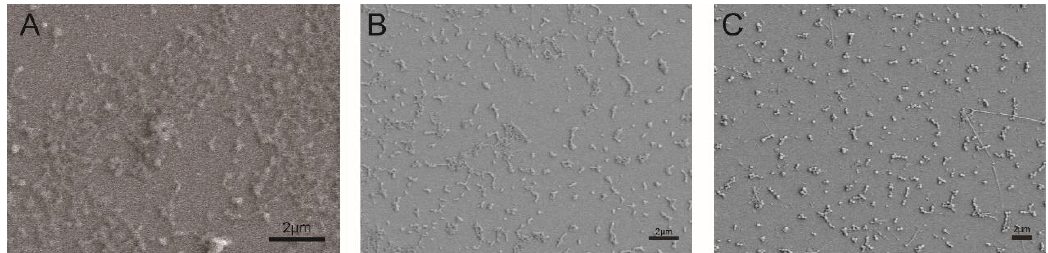
Figure 3. Scanning electron microscopy (SEM) morphologies of the nanocapsules ( A ) maleic rosinpolyoxypropylene-polyoxyethylene ether sulfonate (MRES); ( B ) polyvinyl alcohol (PVA); and ( C ) polycarboxylate (PC)).